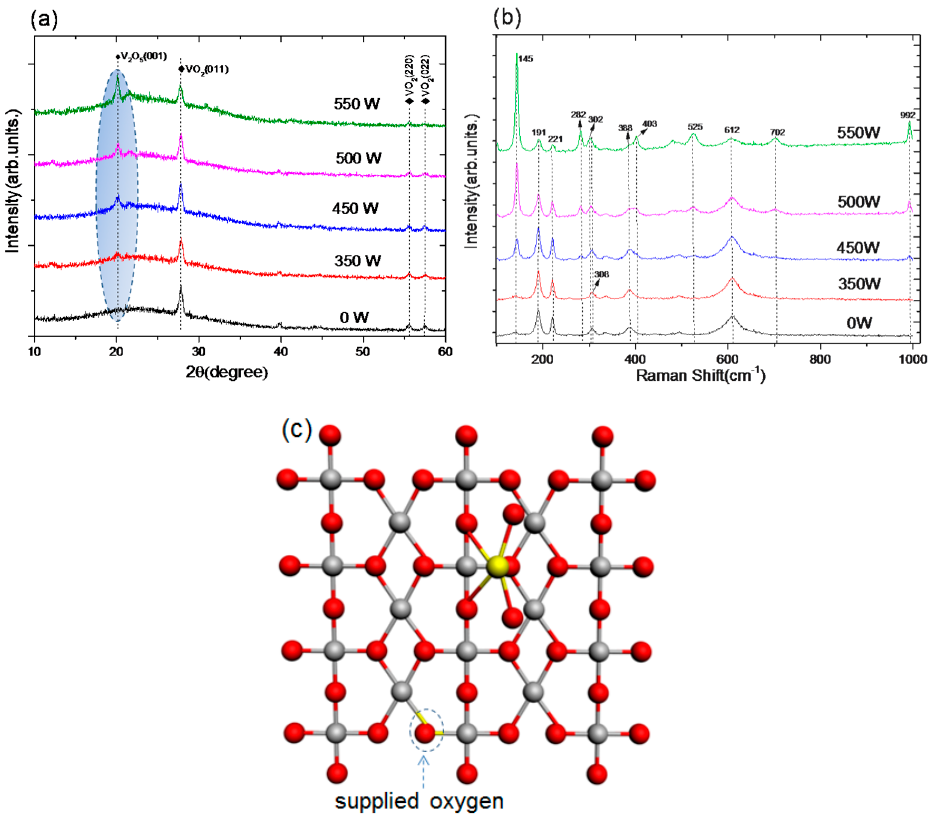
Figure 1. ( a ) X ‐ ray diffraction (XRD) patterns of VO 2 films irradiated with Ar/O plasma at different powers; ( b ) Raman spectra of Ar/O plasma irradiated VO 2 films with different powers; ( c ) top ‐ view of the VO 2 cluster model showing the binding sites, the silver and red spheres represent V(+4) and oxygen atoms, and the solitary yellow sphere a V(+5) atom.